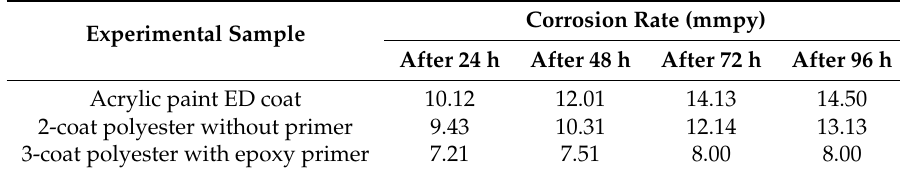
Table 5. Corrosion rate of samples after 24, 48, 72, and 96 h of salt spray